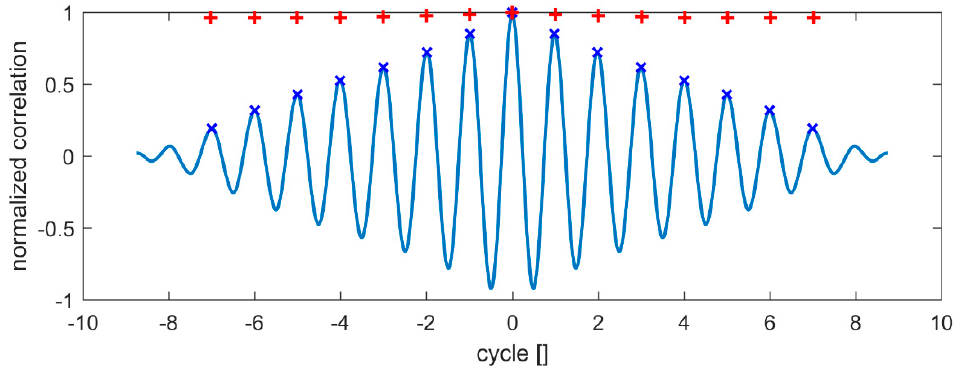
Figure 9. Peaks of normalized autocorrelation function of the zig-zag motion profile for a selected flap in air (red symbol “+”) and glycerol (blue symbol “x”) for a total period of 1 min. For illustration, the continuous auto-correlation profile is added for the case of glycerol as a solid line in blue.